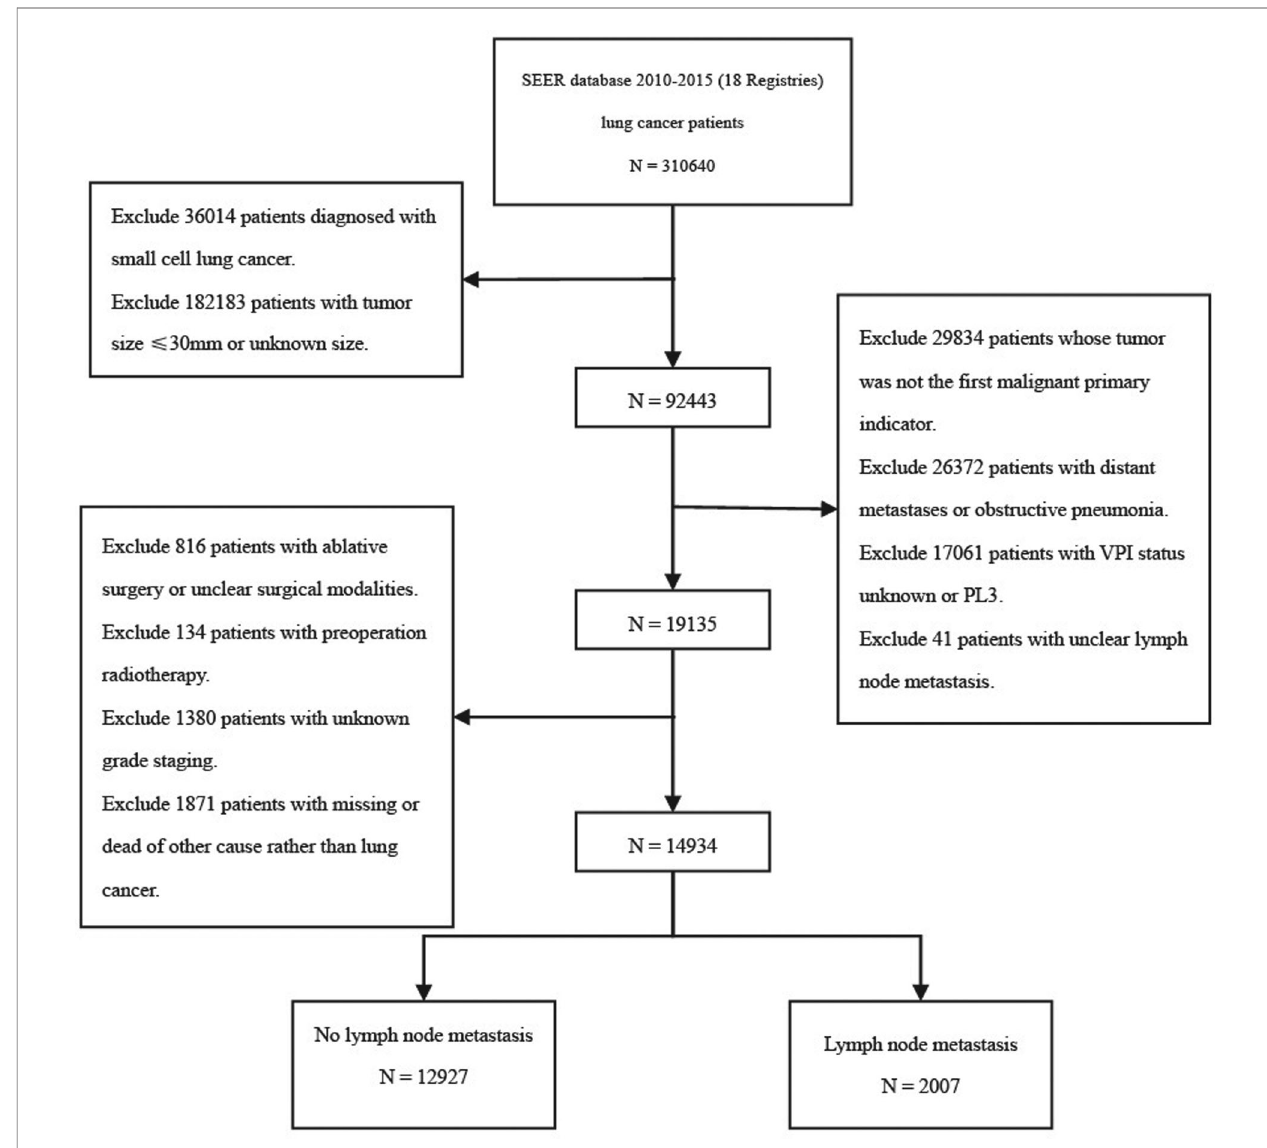
FIGURE 1 | The fl owchart of patients ’ selection